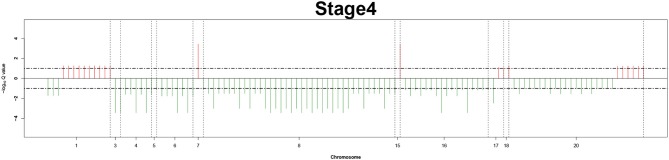
Recurrent genome-wide SCNAs in stage 4. Genome-wide amplifications (red blocks) and deletions (green blocks) in stage 4.